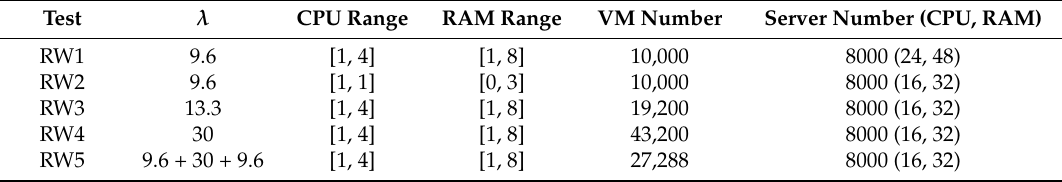
Table 1. Configurations of virtual machines (VMs) and servers in random workloads, RW1 to